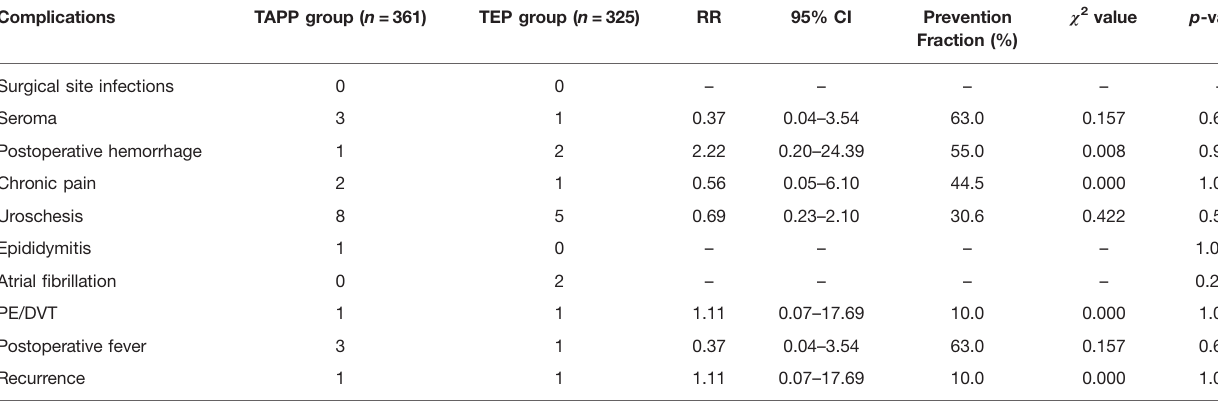
TABLE 3 | Postoperative complications of patients in the TAPP group vs. TEP